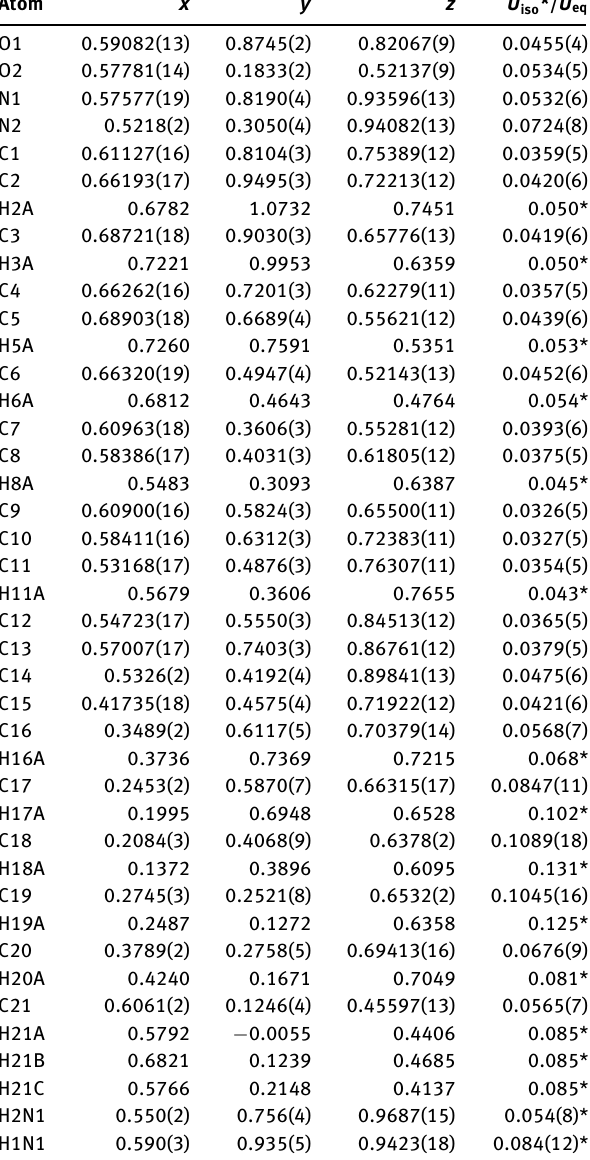
Table 2: Fractional atomic coordinates and isotropic or equivalent isotropic displacement parameters (Å 2